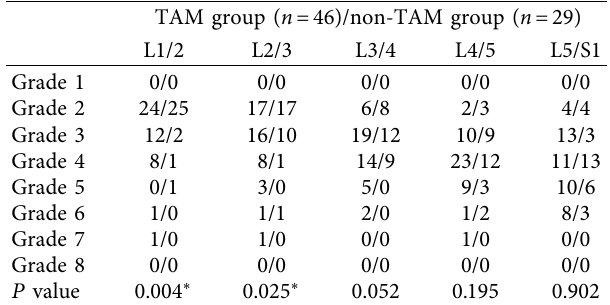
Table 4: Comparisons of modified Pfirrmann grading of L1/2-L5/ S1 IVD between the TAM group and the non-TAM